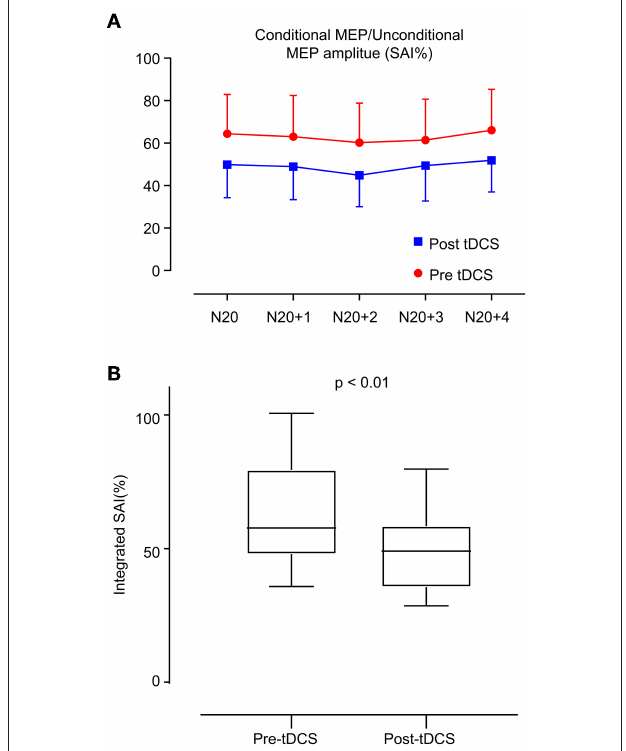
FIGURE 2 | Change in short latency afferent inhibition (SAI). (A) SAI was evaluated in two ways: the red line indicates the estimation of SAI before anodal tDCS, and the blue line indicates the estimation after anodal tDCS. The interstimulus interval is 1ms from N20 to N24. (B) Box plot of integrated SAI (%) distribution before and after anodal tDCS. After anodal tDCS, the SAI (%) showed a significant decrease compared with that before anodal tDCS ( p < 0.01).